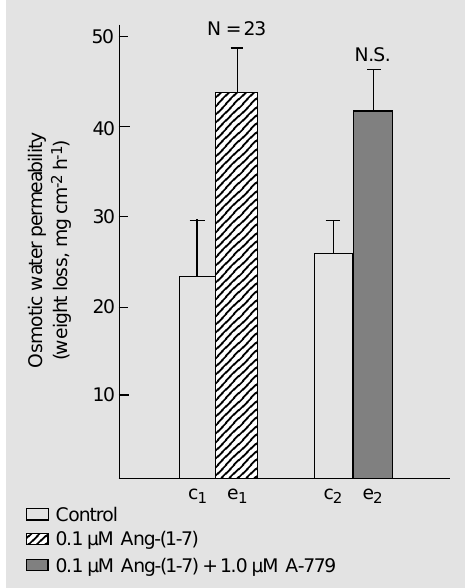
Figure 3 - Time course of the response to Ang-(1-7). A , Mean ± SEM for 10 experiments; B shows the response of a single reactive skin. The maximal responses occurred 20 min after the addition of 1.0 µM Ang-(1-7) to the dermal surface of the skins.